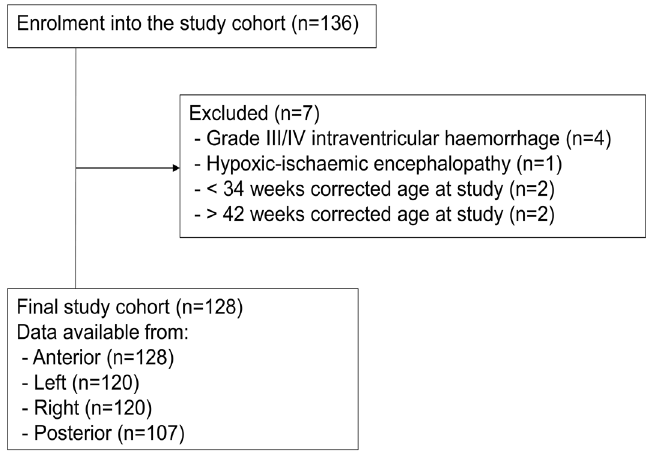
Figure 1. Profile of the study population. A diagram depicting the flow of the study